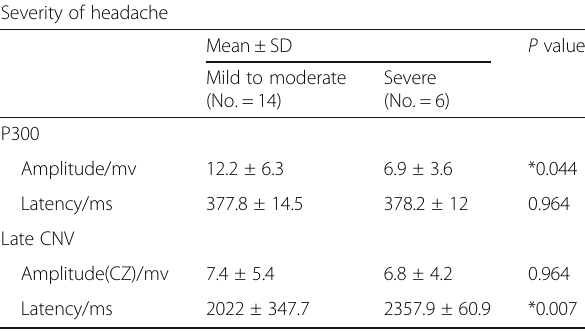
Table 3 Comparison between results of NP tests in patients of group I as regards severity of